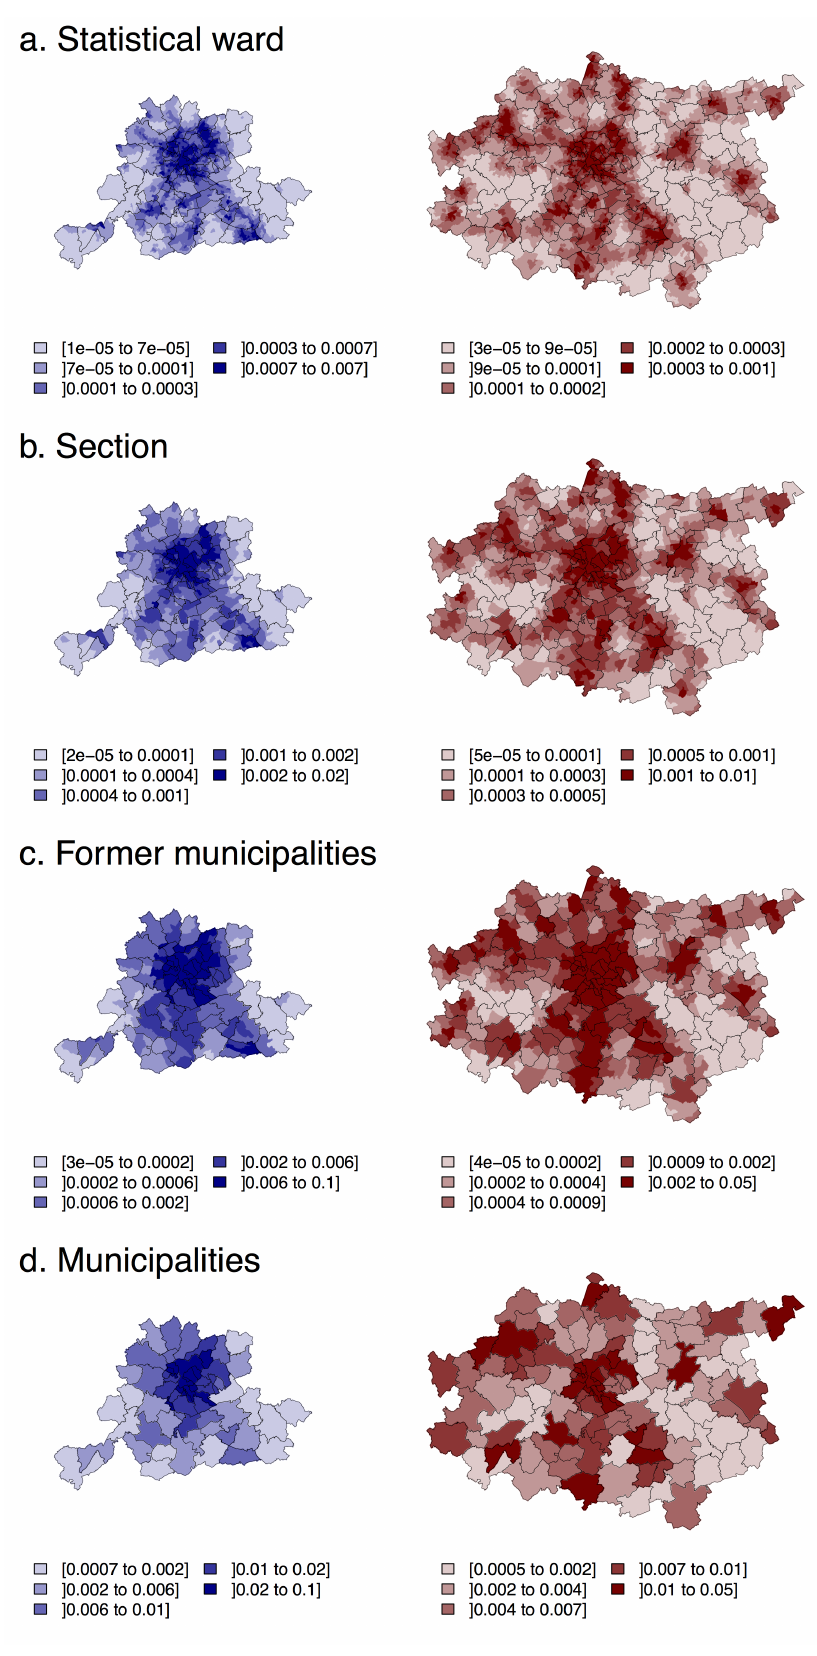
Figure 3: Predicted probability of location for Monocentric (left) and Polycentric (right) case studies. Discretization: